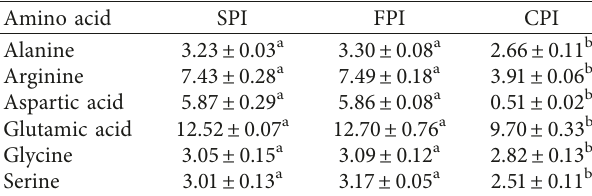
Means with the similar letter in a row are momentously alike. SPI � sesame protein isolates, FPI � flaxseed protein isolates, and CPI � canola protein